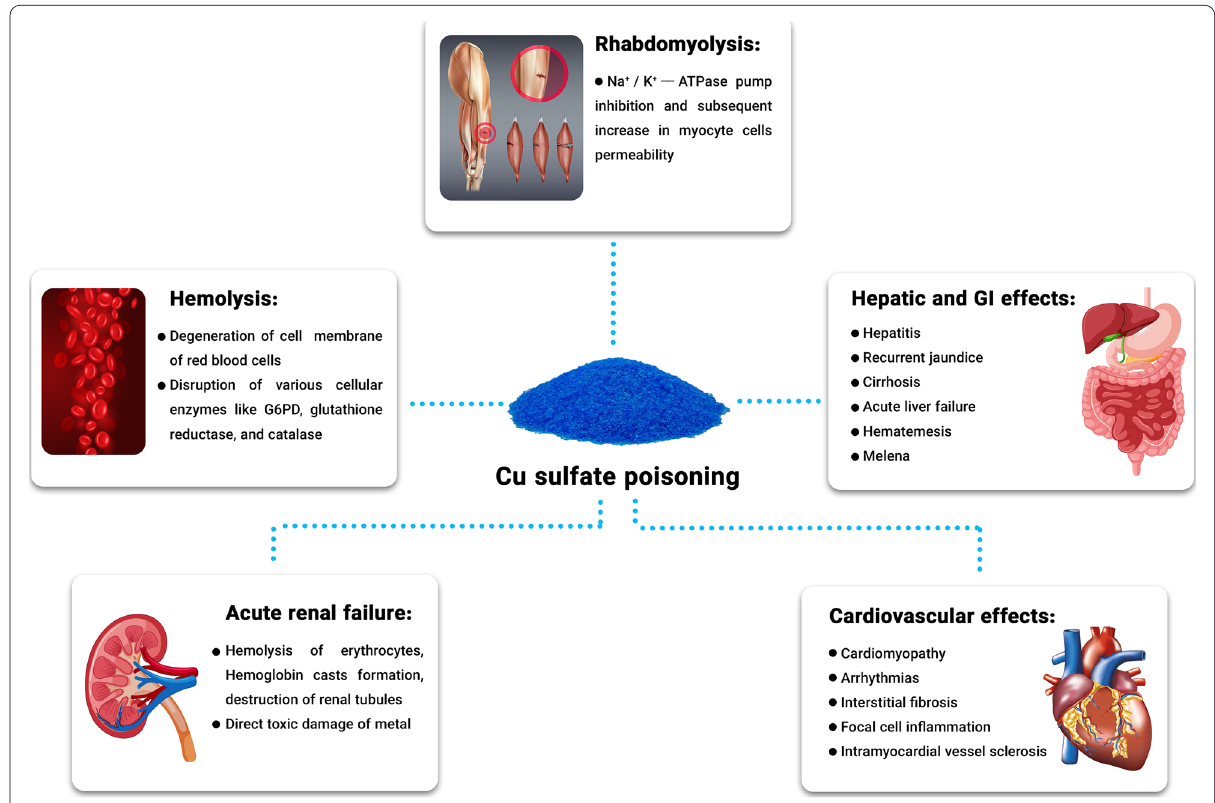
Fig. 1 Clinical features of copper sulfate